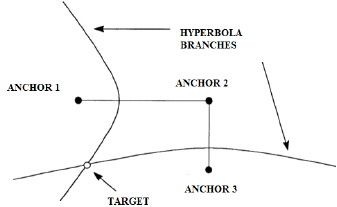
Figure 10. Intersection of hyperboles that identify the position of the target.